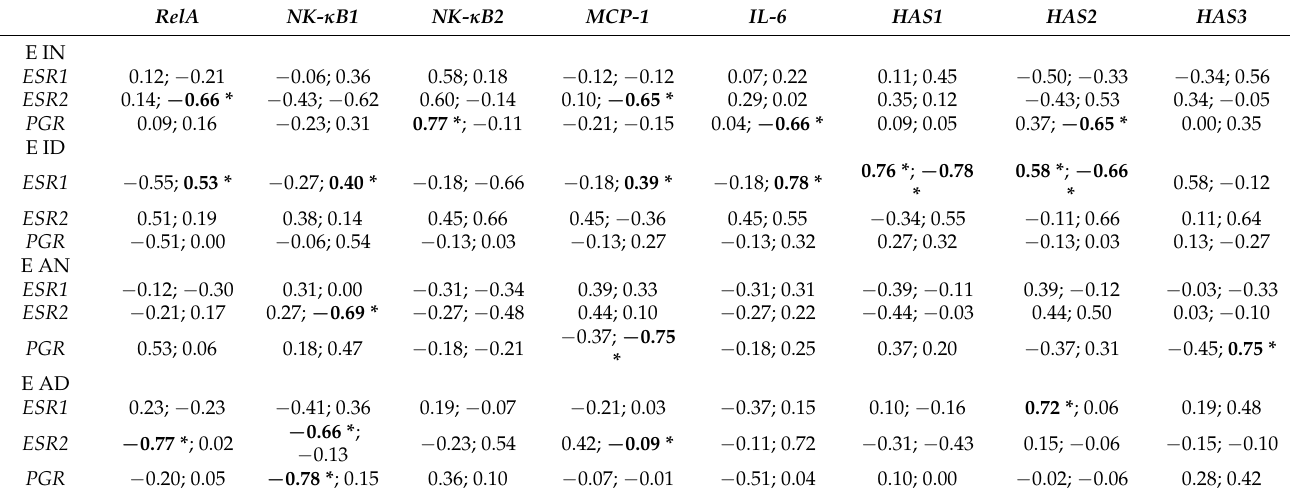
Table 2. Spearman’s correlation coefficient ( ρ ) between transcription levels of ovarian steroid recep- tors ( ESR1 , ESR2 , PGR ) and transcription levels of selected proteins of the nuclear factor κ B (NF- κ B) signaling pathway ( RelA , NK- κ B1 , NK- κ B2 , MCP-1 , IL-6 , HAS1 , HAS2 , HAS3 ) in equine endometrium classified according to different histopathological types of endometrosis (E IN, E ID, E AN, E AD). The value of ρ is reported for the follicular (FLP) and mid-luteal (MLP) phases of the estrous cycle. In one cell in the table, both ρ values are reported as ρ for FLP; ρ for